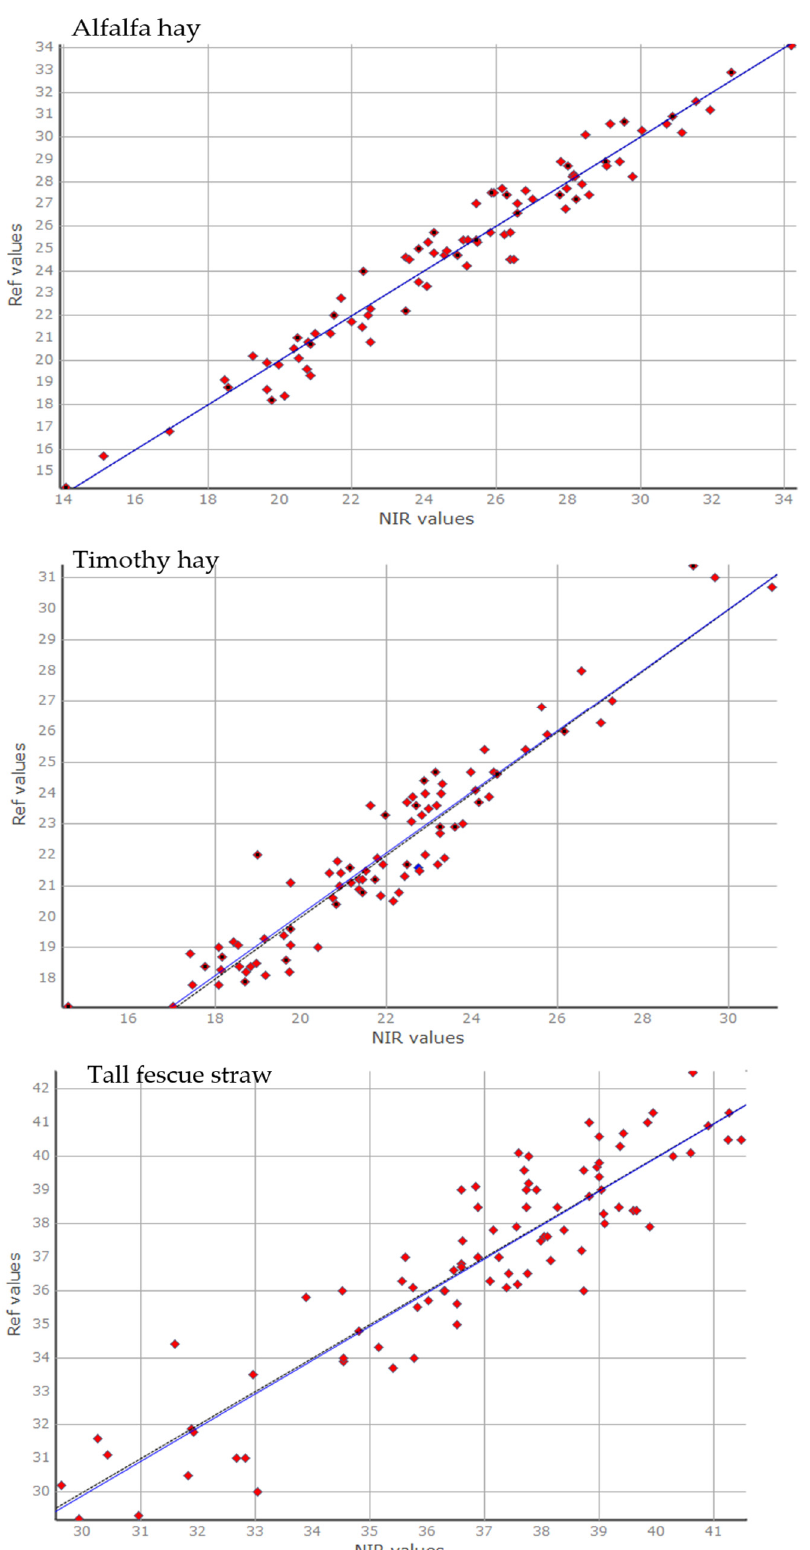
Figure 2. Plots of reference (observed) versus NIRS values (predicted) of undigested aNDFom concentration of alfalfa hay, timothy hay, and tall fescue straw (experiment 2). Plots were created using a calibration dataset that was devoid of outliers.